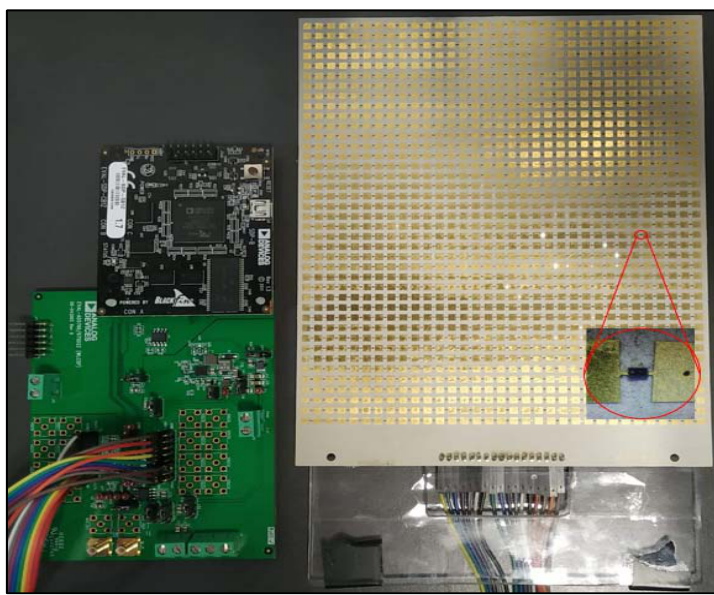
Figure 7. The prototype front side with a zoom ‐ in view on the varactor which is located between each two adjacent unit cells. On the left is the DAC for the DC voltage bias.